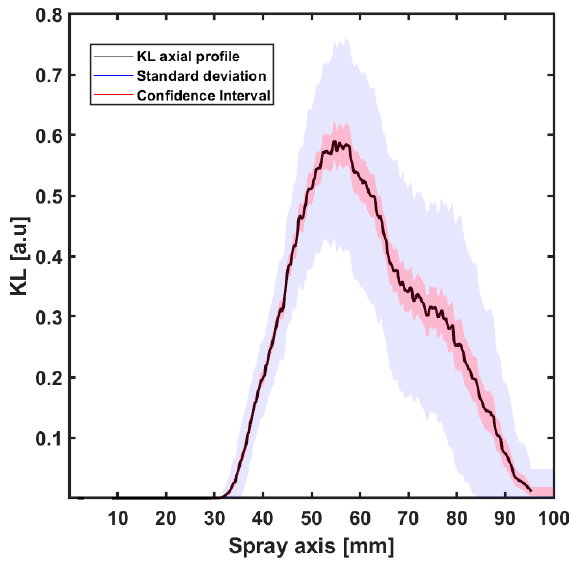
Figure 2. KL profile on the spray axis for diesel at nominal case in the time instant 3500 µ s.